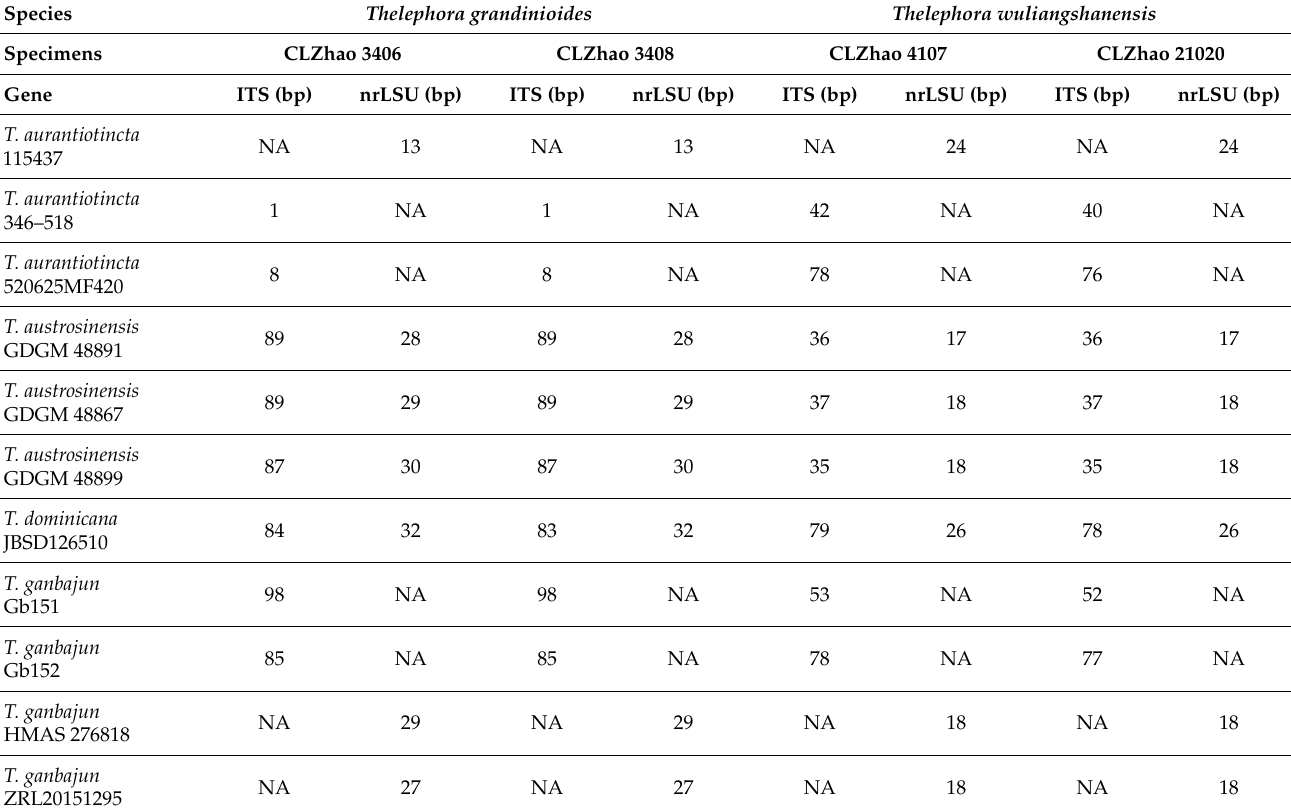
Table 2. The nucleotide differences of phylogenetically similar species to Thelephora grandinioides and T . sikkimensis . Species Thelephora grandinioides Thelephora wuliangshanensis CLZhao 3406 CLZhao 3408 CLZhao 4107 CLZhao